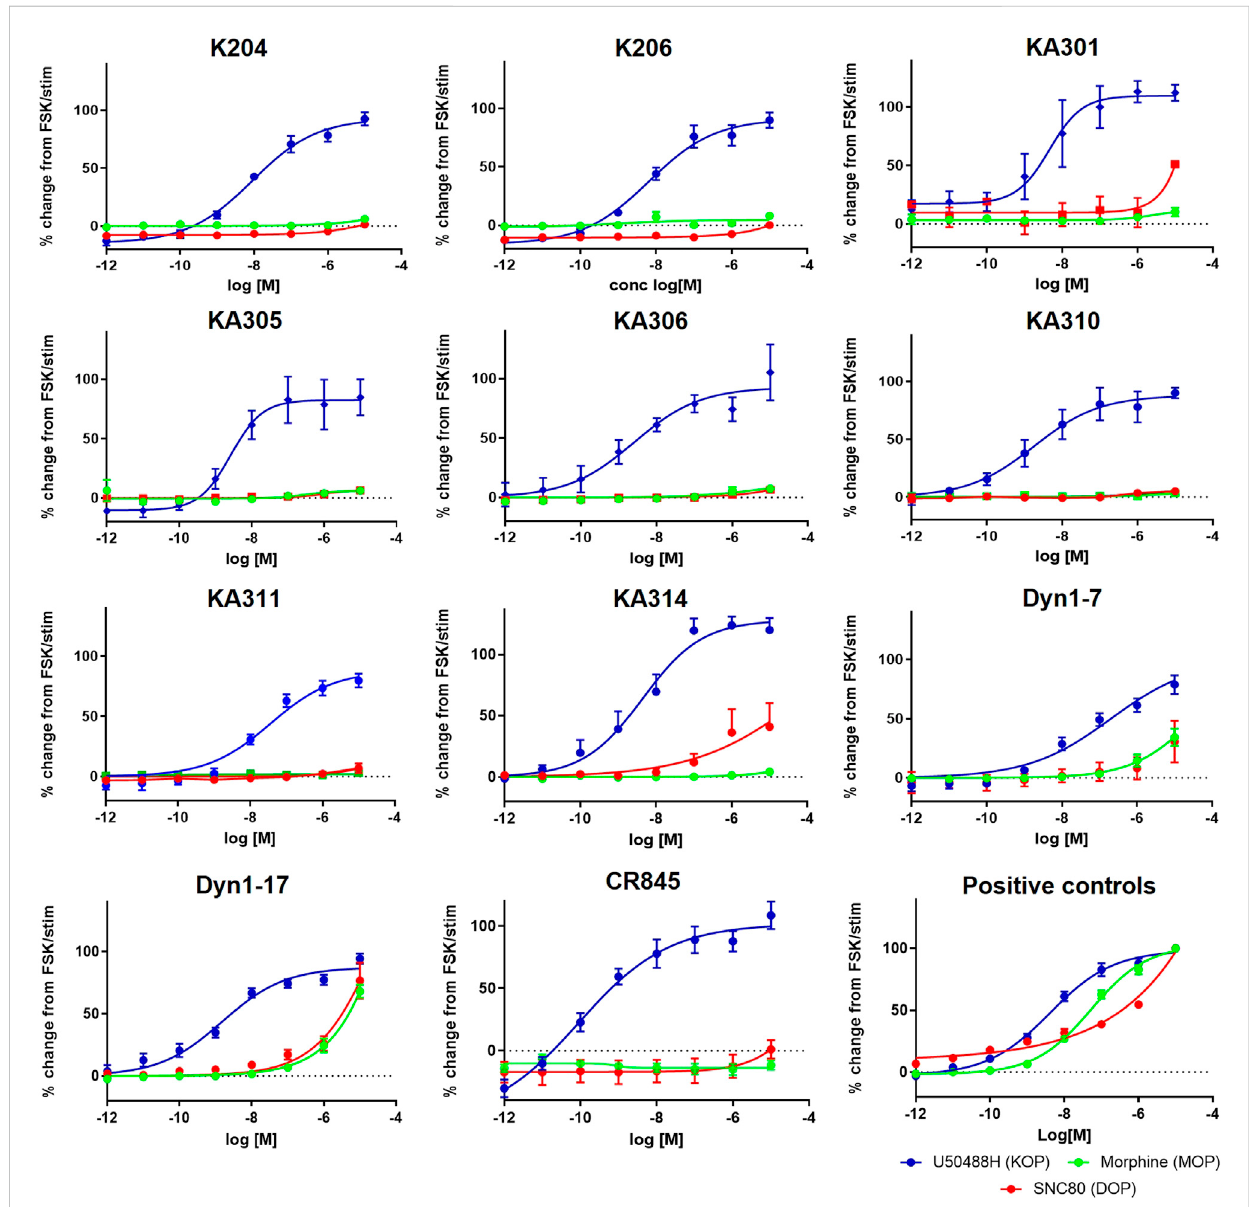
FIGURE 1 Concentration-response curves of the most promising selected peptides in the cAMP assay, compared to positive control compounds and reference peptides Dyn1-7 and Dyn1-17. HEK293-KOR cells; blue. HEK293-MOP cells; green. HEK293-DOP cells; red. Y -axis shows percentage change incAMPproductionnormalisedtoFSKasmaximalproductionandcleanstimulationbufferasbaselinecAMPexpression(0%).Datashownisanaverageof a minimum of three independent experiments, each in duplicates, mean ±